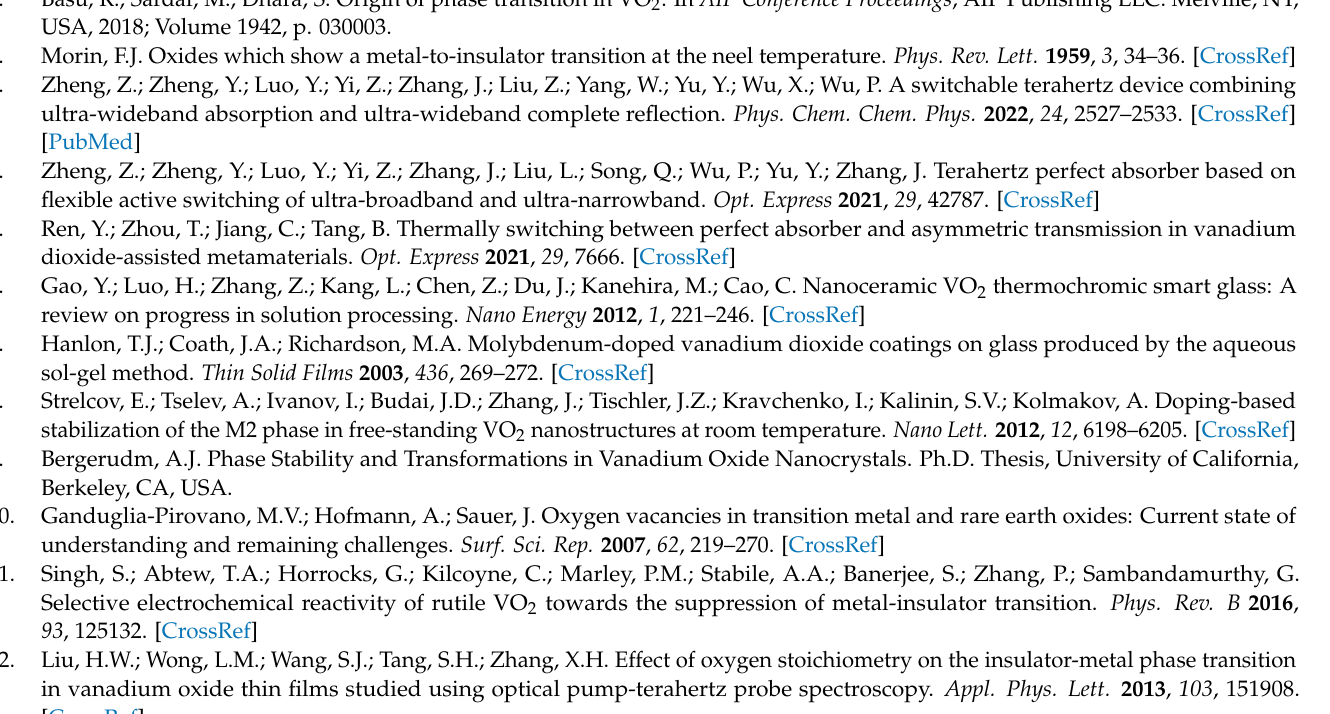
based phase transition devices. Figure S2: Topographical analysis of MoO 3 (a) and WO 3 (b). Figure S3: Transmission spectra (T) of the single-layer thin films. Figure S4: (a) FTIR spectra of samples S1–S6 at room temperature. (b) UV-Vis-NIR spectra of samples S1–S6 at room temperature. (c,d) the refractive index and extinction coefficient of S1–S6 thin films with wavelengths. Figure S5: (a) and (b) represent the plot of (Ln α ) versus photon energy and the Urbach energy (Urbach tail) with bandgap for S1–S6 thin films, respectively. References [65–69] are cited in the supplementary